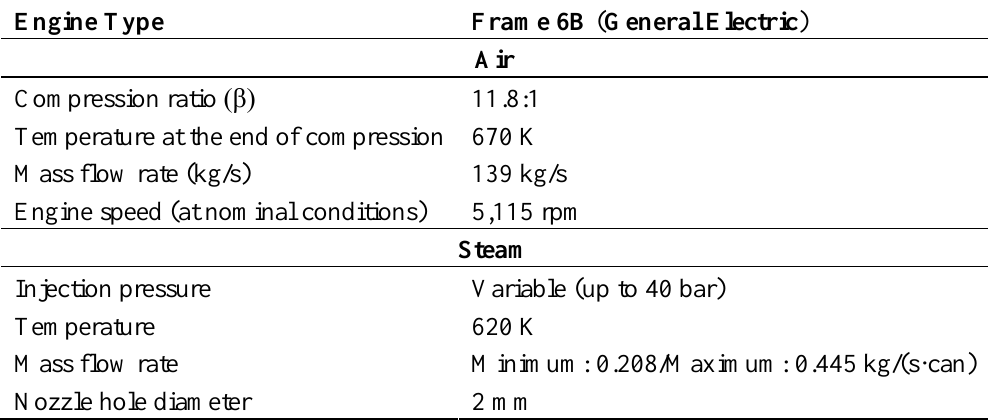
Table 1. Gas turbine specifications at the design condition.